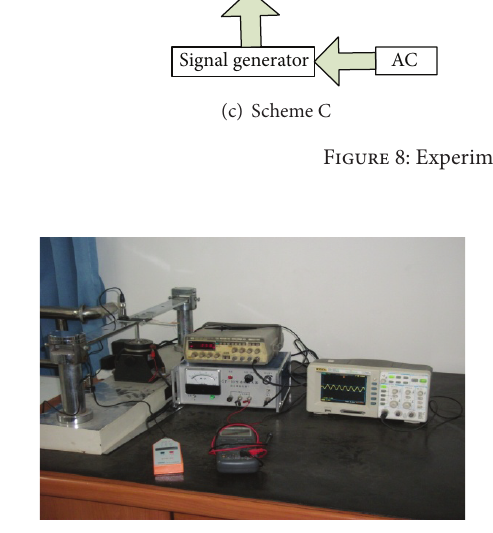
scheme D. The adjustable frequency range is about 4.1 Hz.